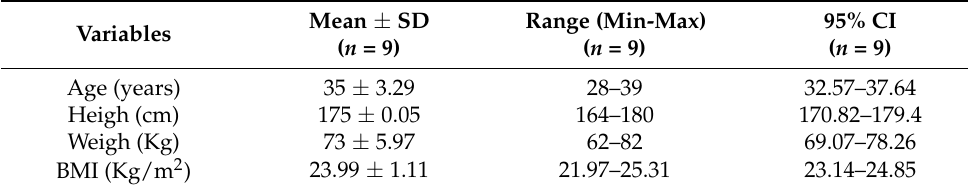
Table 1. Anthropometric and sociodemographic